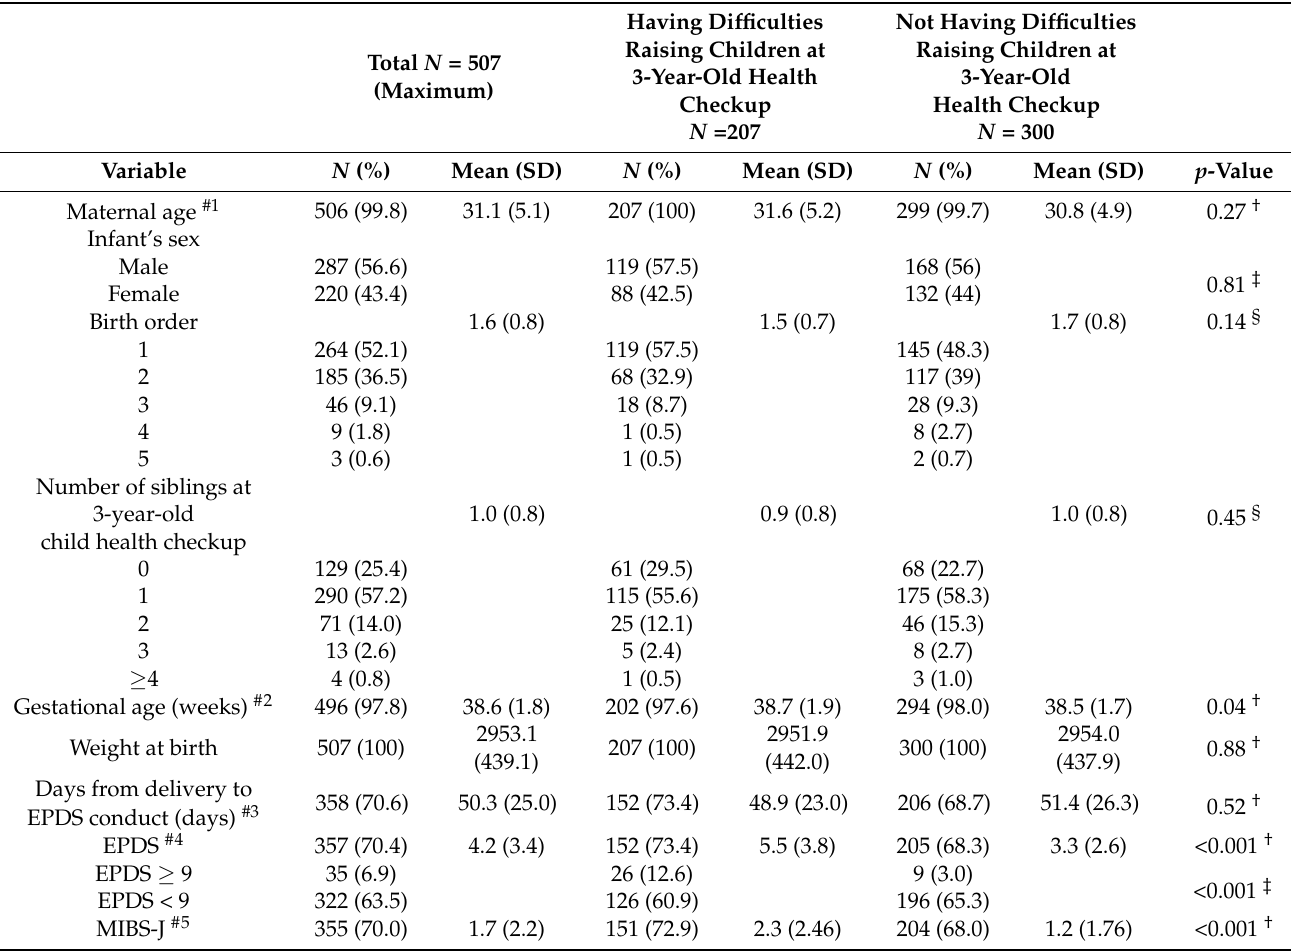
Table 1. Demographic characteristics and background information of those having difficulties raising children versus those not having difficulties raising children at 3-year-old health